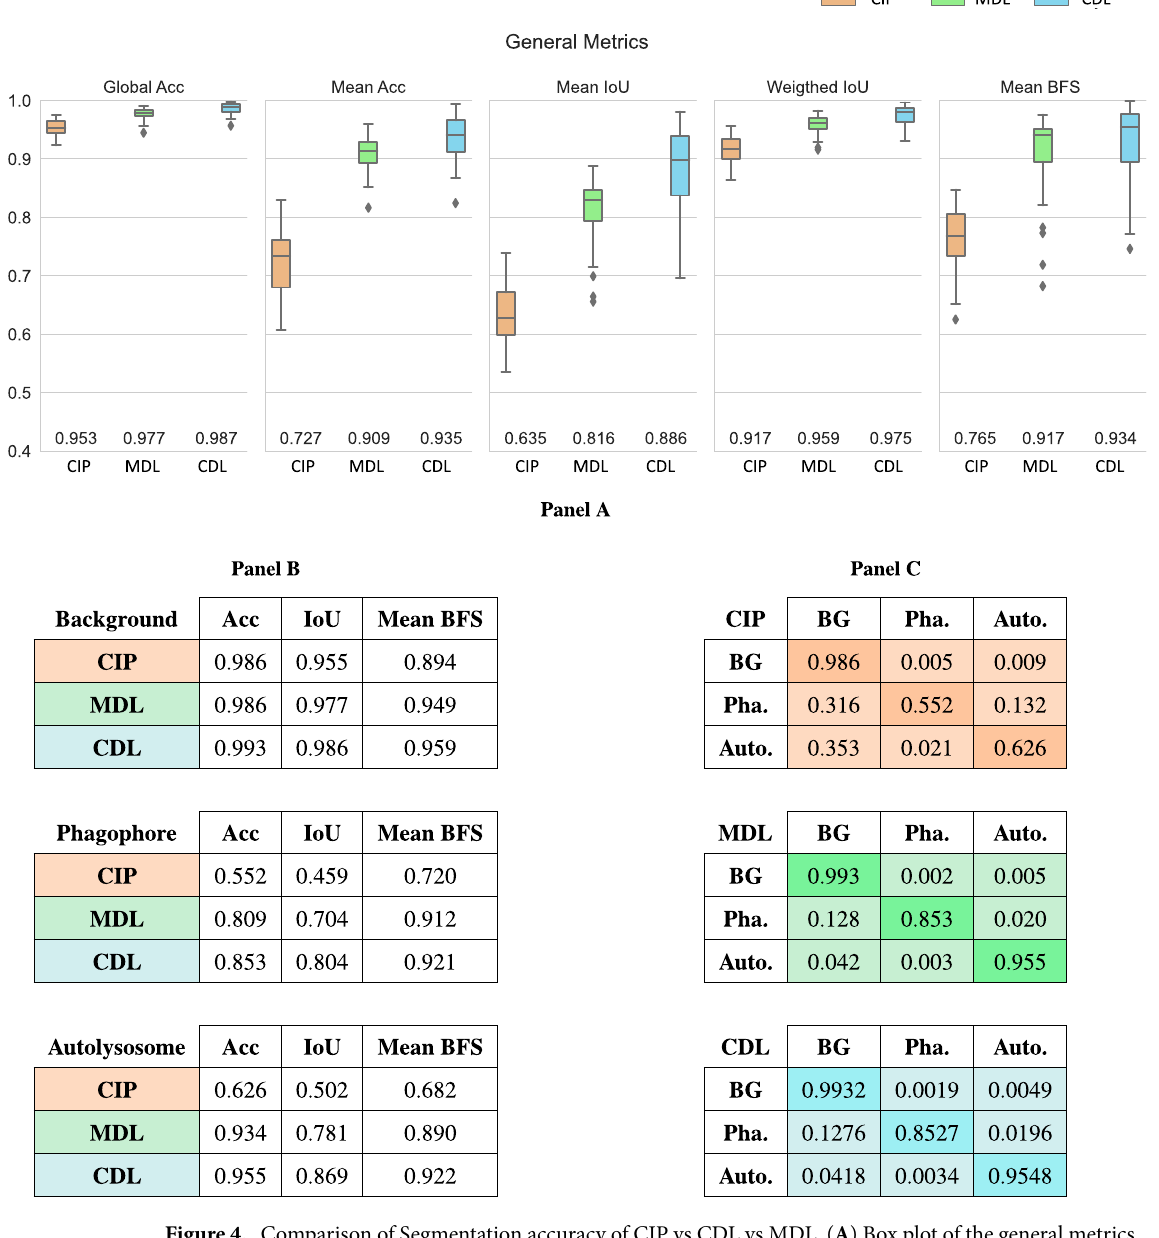
Figure 4. Comparison of Segmentation accuracy of CIP vs CDL vs MDL. ( A ) Box plot of the general metrics scores of the three different approaches. Mean aggregation is recommended over Global and Weighted for our strong-class imbalanced dataset. ( B ) Accuracy, Intersection over Union and Mean BFS of the three methods for each class: Background, Phagophore and Autolysosome. The large class imbalance between background and the other classes explains the small differences in performance for the background class. In these regards, Mean BFS is a more representative metric for imbalanced scenarios. ( C ) Confusion matrix for each approach. Each row